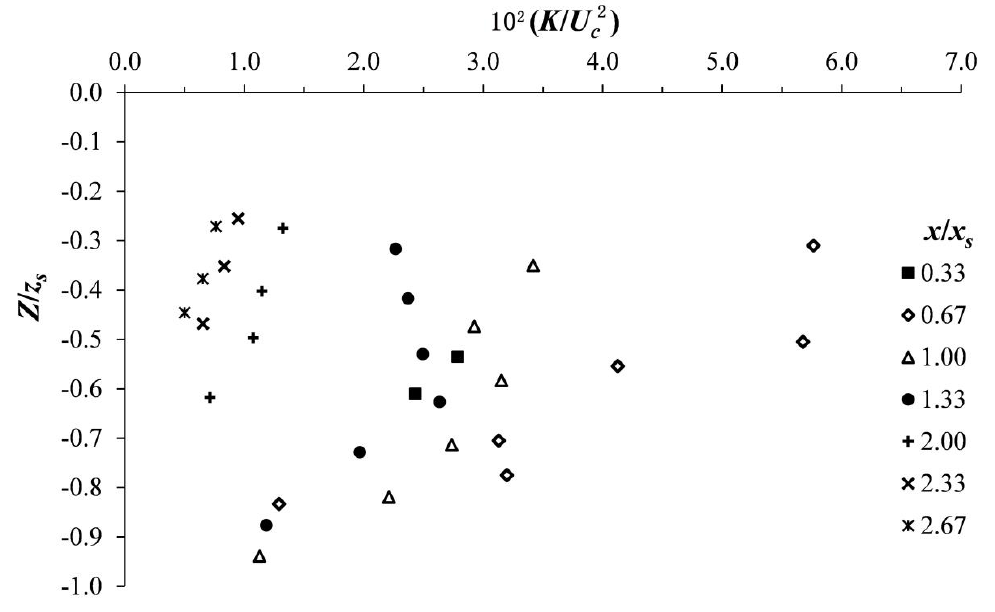
Figure 6. Vertical profiles of normalized turbulent kinetic energy, k / U c 2 , in scour hole and at di ff erent downstream positions x / x s along the plane of flow symmetry ( y =